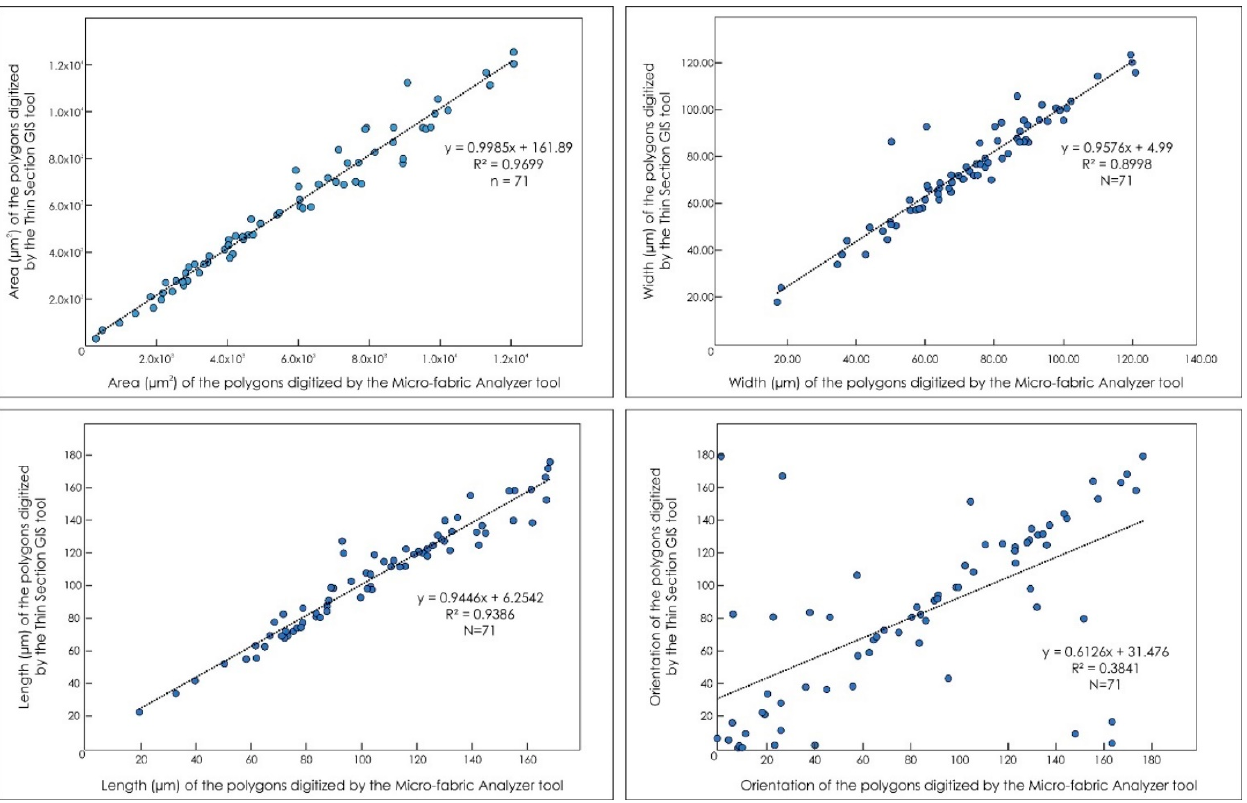
Figure 12. Relationships between the areas, the lengths of the short (width) and long axes, and orientation of the grains derived by the TSG and the MFA.